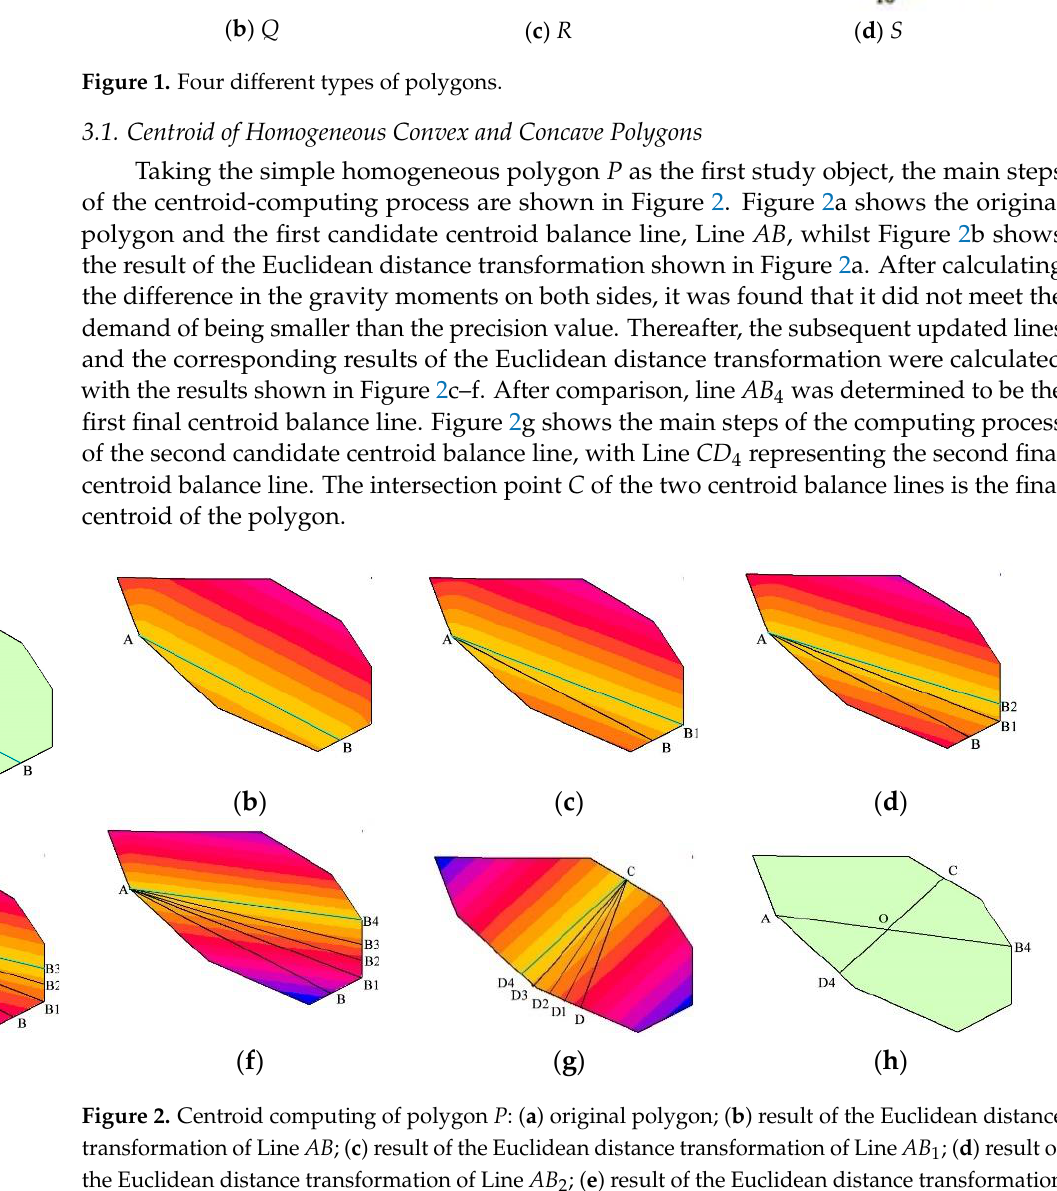
Figure 1. Four different types of polygons.